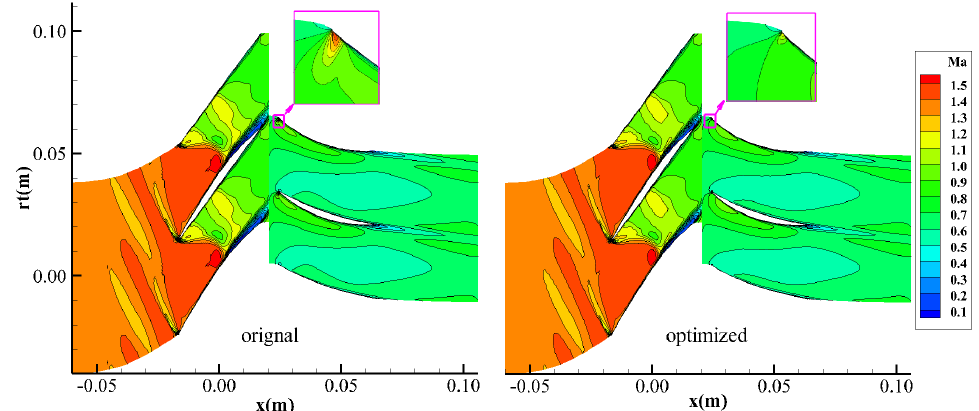
Figure 19. Mach number contours at the middle span for the NASA Stage 35.